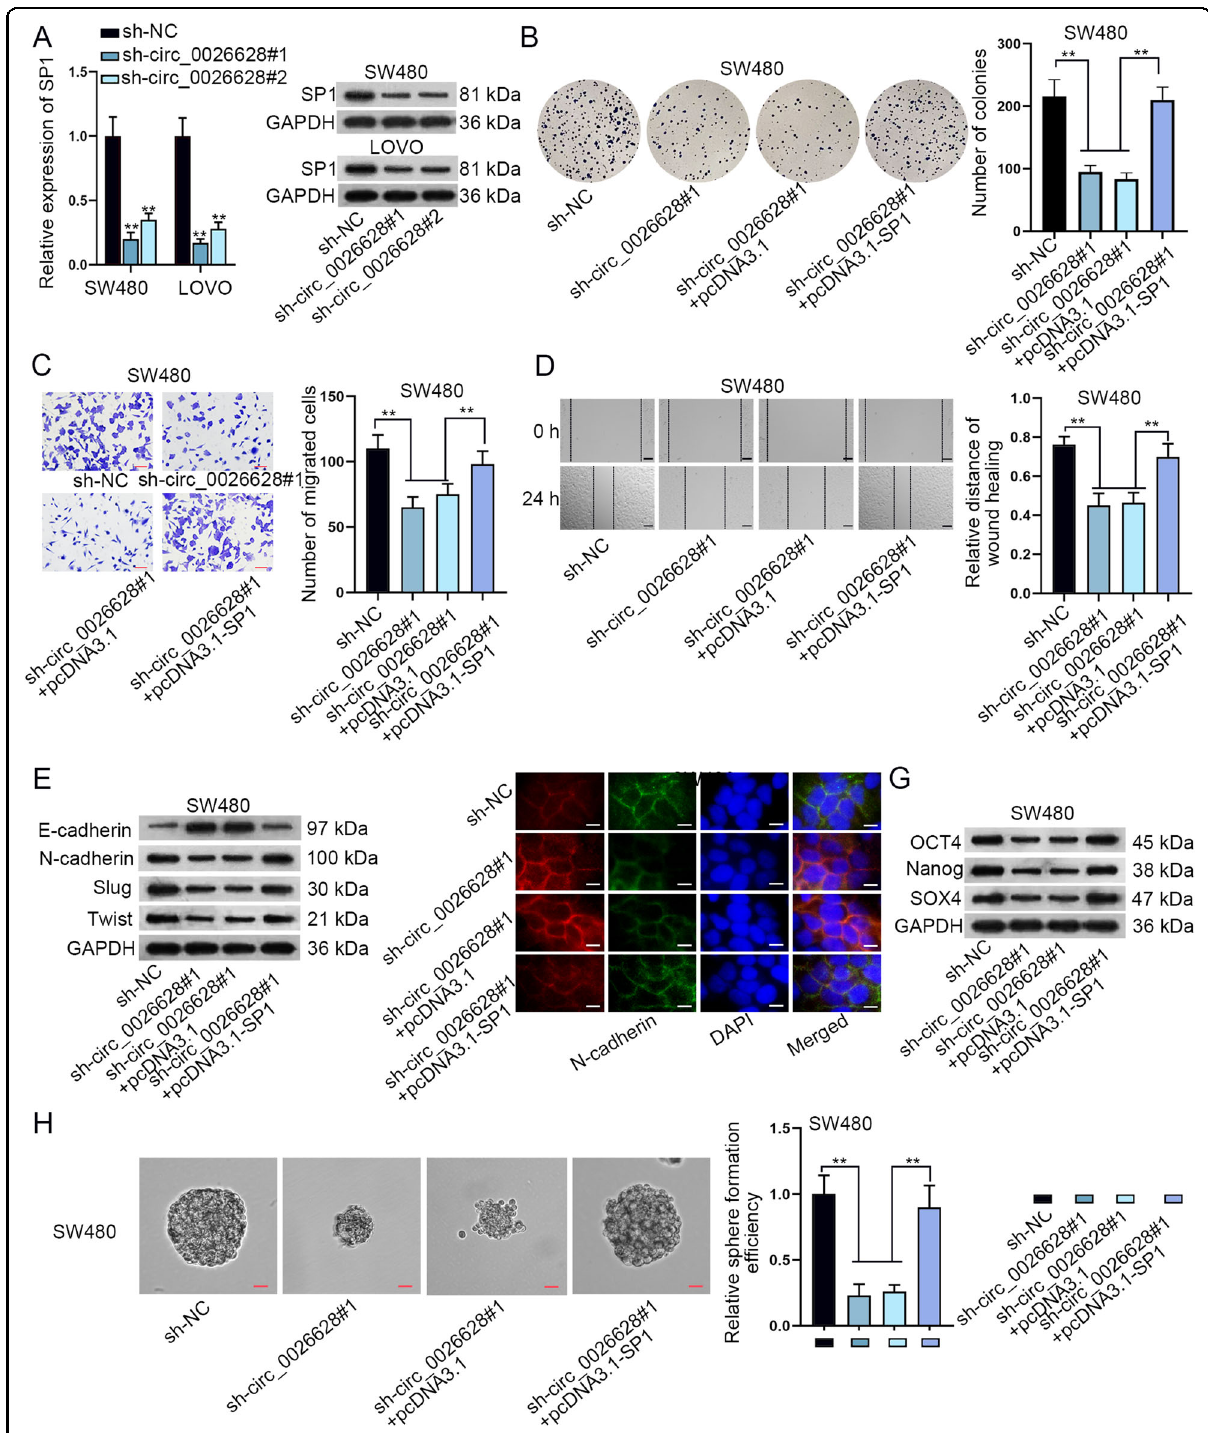
Fig. 3 SP1 was required in circ_0026628-mediated biological functions of CRC cells. A qRT-PCR and western blot measured the in fl uence of silenced circ_0026628 on SP1 expression in CRC cells. One-way ANOVA. B – D . Colony formation, transwell (scale bar: 180 μ m) and wound-healing assays (scale bar: 120 μ m) examined the rescue effects of SP1 overexpression on circ_0026628 de fi ciency hampered cell proliferation and migration. One-way ANOVA. E , F Western blotting and IF staining assay (scale bar: 150 μ m) detected changes in EMT process in indicated CRC cells. G , H Western blot and sphere formation assay (scale bar: 150 μ m) explored the stemness of CRC cells under different transfections. One-way ANOVA. ** P <